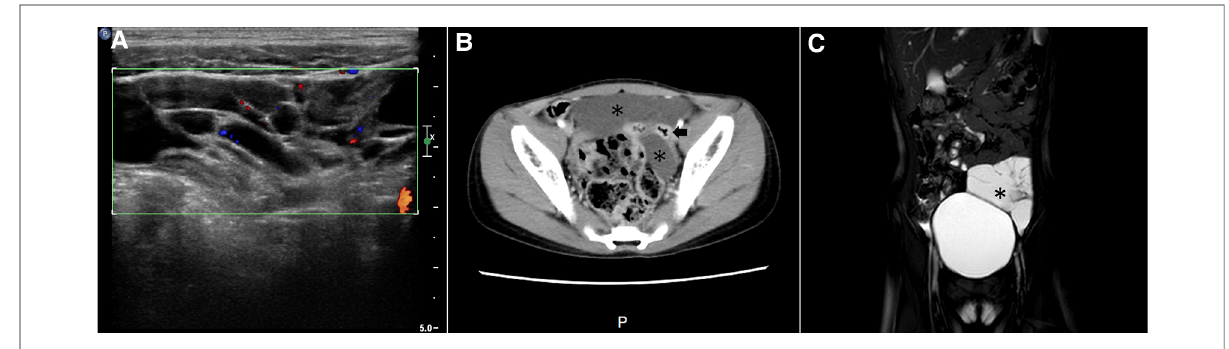
FIGURE 1 Imaging examination of a patient with a dumbbell-type ileal mesenteric cyst. ( A ) Sonography demonstrated a hypoechoic cyst with multiple internal septations; ( B ) enhanced CT scan showing a cyst (asterisk) located on both sides of the intestine (arrow), without contrast enhancement; ( C ) MRI showing an irregular cyst (asterisk) with a sharp margin and septation on a T2-weighted image.